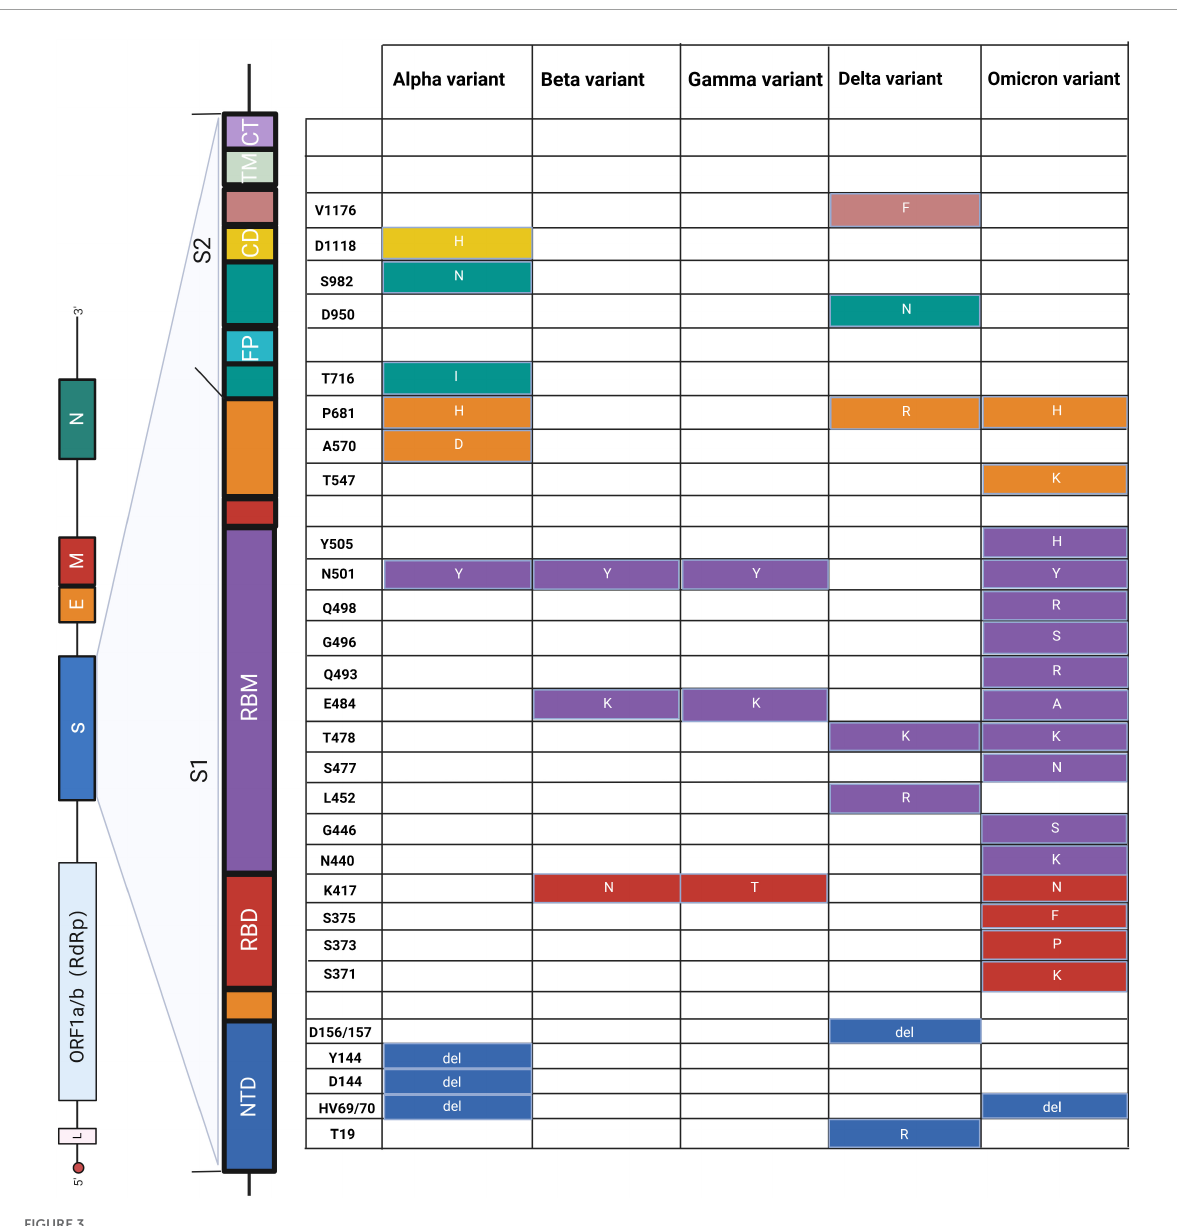
FIGURE3 Schematic diagram of amino acid mutations in the S gene of SARS-CoV-2. The left panel shows the genome of SARS-CoV-2 and the detailed structure of the S gene. The S1 and S2 subunits and a transmembrane domain constitute the spike protein (S). RBD and RBM bind to the host cell receptor. S2 consists of FP, CD, and CT, contributing to membrane fusion. Substitutes of amino acids of mutations are presented on the right panel , and the colors correspond to the structure of the S gene. NTD, N-terminal domain; RBD, receptor-binding domain; RBM, receptor-binding motif; FP, fusion peptide; CD, connecting domain; TM, transmembrane domain; CT, cytoplasmic tail. Alpha (Berenger et al., 2021; Borsova et al., 2021; Hale et al., 2021; Fu et al., 2022; Oh et al., 2022; Ratcliff et al., 2022), beta (Hale et al., 2021; Dikdan et al., 2022; Fu et al., 2022), gamma (Hale et al., 2021; Ratcliff et al., 2022), delta (Berenger et al., 2021; Hale et al., 2021; Norz et al., 2021; Oh et al., 2022; Rosato et al., 2022), and omicron (Bloemen et al., 2022; Dachert et al., 2022; Rasmussen et al.,